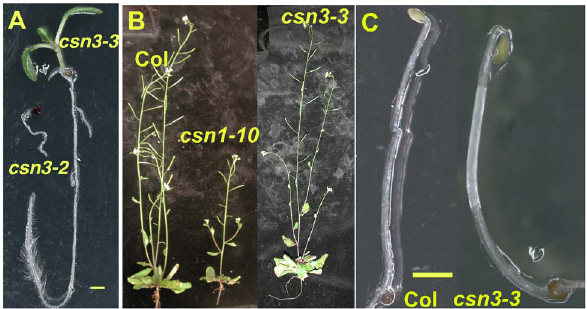
Figure 3. csn3-3 does not exhibit characteristic csn mutant phenoytpes. ( A ) Seedling phenotypes of csn3-2 and csn3-3 mutants. ( B ) Phenotypes of Col, csn1-10 and csn3-3 adult (30-d.o.) plants. ( C ) 5- d.o. Col and csn3-3 etiolated seedlings. Size bars=1 mm.